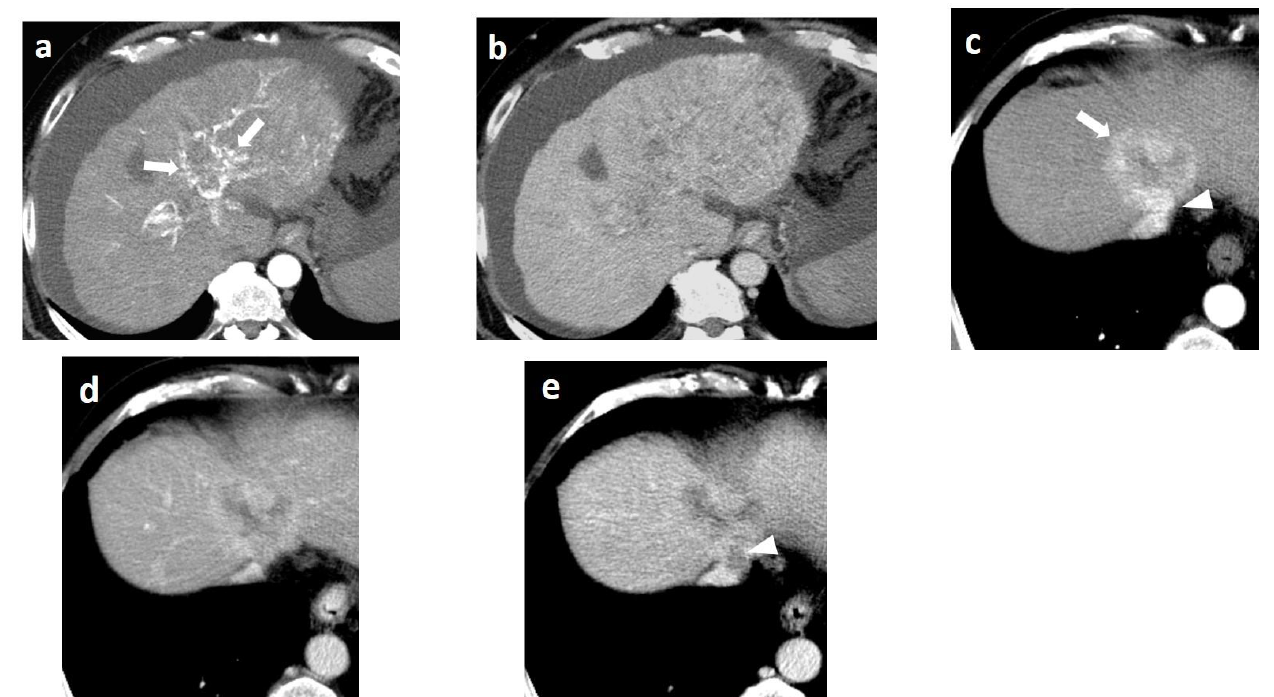
Figure 7. HCC with atypical imaging features; Cirrhotomimetic HCC ( a , b ) and Progenitor-type HCC ( c , d , e ) (late arterial, portal, and delayed phase, respectively). ( a , b ): Cirrhotomimetic HCC with TIV. There is marked diffuse heterogenous appearance of the left liver lobe with subtle arterial enhancement and “wash-out” accompanied with hyperenhancing portal vein tumor thrombus, displaying prominent neovascularity (thread and streak sign) ( a ) (arrows). ( c , d , e ): Progenitor-type HCC. There is a mass with irregular, non-smooth arterial enhancing rim (arrow). Note also the enhancing tissue inside the middle hepatic vein (arrowhead) ( c ) protruding into the IVC (arrowhead) ( e ). With the exception of cHCC-CCA, TIV is consider a fairly specific feature of HCC in a cirrhotic liver since ICC more frequently encases rather than invades veins.